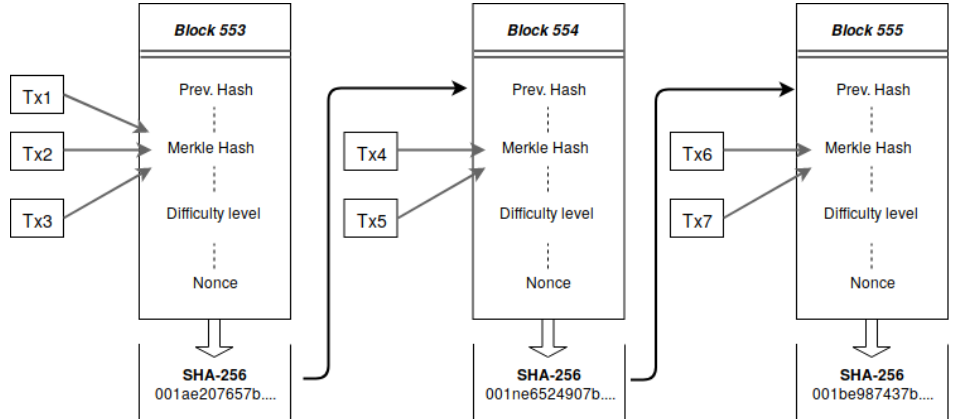
Figure 2. A partial layout of bitcoin blocks, where each block is chained to each other. Tx1, TX2, and TX3 are hashed through the Merkle tree process. The Merkle hash adds a nonce value sequentially to generate a new Hash and then compare it to the difficulty level. The entire data string produces a hash value, which is then added to the next block by forming a chain of